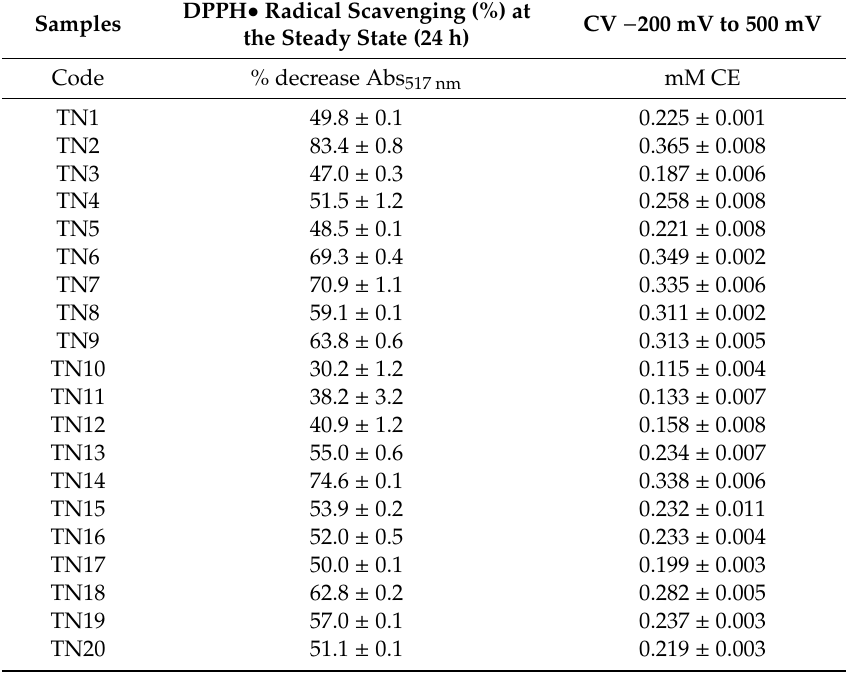
Table 3. DPPH • radical scavenging values (%) at the steady-state (24 h incubation time), and